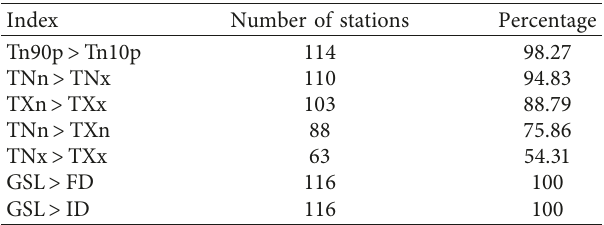
Figure 3: Presentation of regional time series for extremely cold temperature indices. (a) Cold night frequency (TN10p). (b) Annual minimum value of daily minimum temperature (TNn). (c) Annual minimum value of daily maximum temperature (TXn). (d) Frost days (FD). (e) Diurnal temperature range (DTR). The heavy bold solid black line is an annual smoothing mean. Table 3: Number and percentage of stations where the linear trend of one index is of greater magnitude than that of the